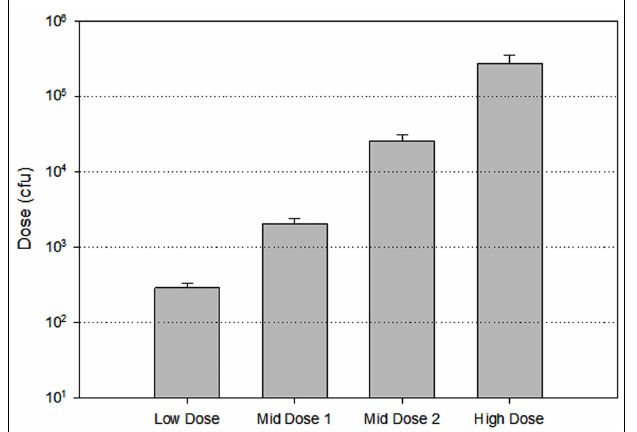
FIGURE 2 | Mean acute single day low-dose inhalation challenge data. The figure illustrates the mean inhaled dose (bars) with standard deviation compared to the target doses (dashed horizontal log increment lines).The low-dose target was 10 2 , the mid-dose1 target was 10 3 , the mid-dose 2 target was 10 4 , and the high-dose target was 10 5 .